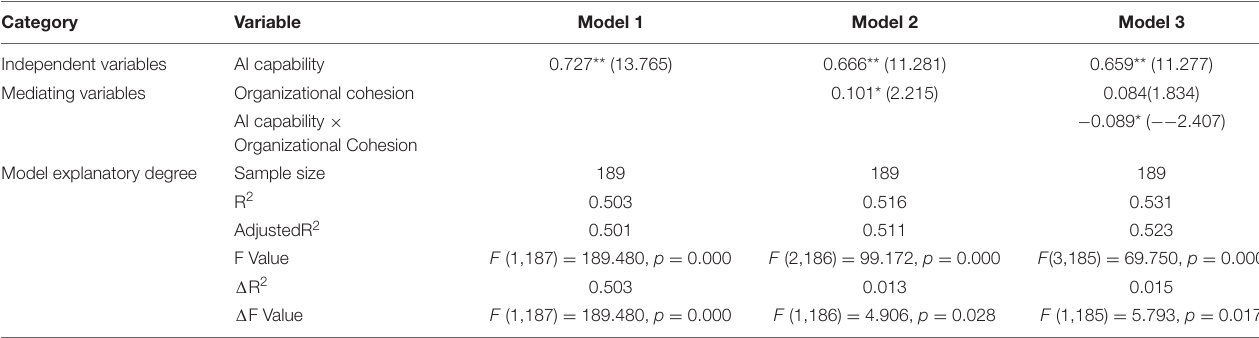
TABLE 9 | Multilevel regression test results (Explanatory variable: Knowledge